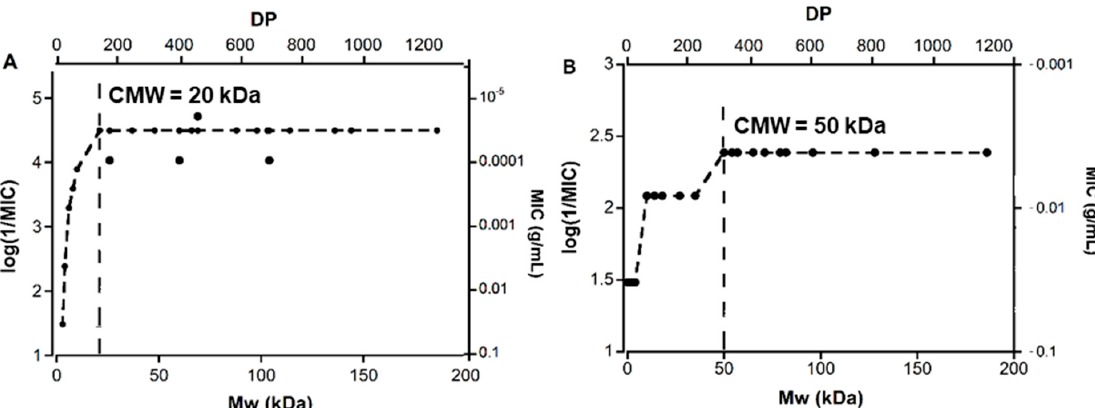
Figure 5. Figure showing the variation of the antibacterial activity of TMC ( A ) and chitosan ( B ) with M w ; CMW = critical mole weight for high activity; DP = Degree of Polymerisation. In the Figure, MIC values were converted from mg/mL to g/mL for clarity. Since similar MIC values were obtained in replicate measurements, no experimental error is reported.